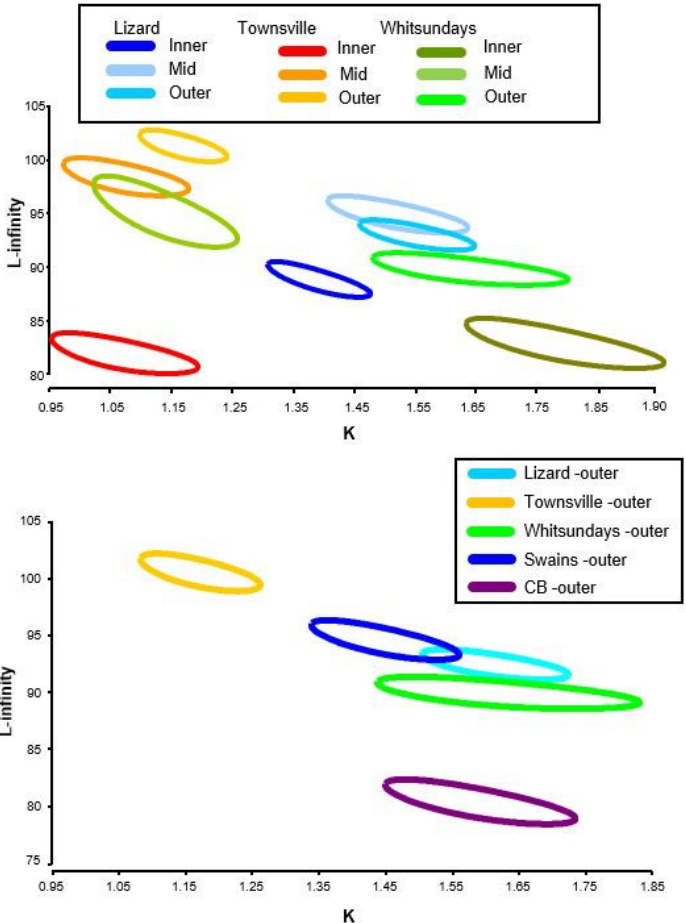
Figure 6. Kimura plots showing 95% confidence ellipses for the parameters K (growth coefficient) and L ∞ (mean asymptotic length) for (A) latitudes with inner mid and outer collection reefs and (B) latitudes where collections where only made at outer reefs.